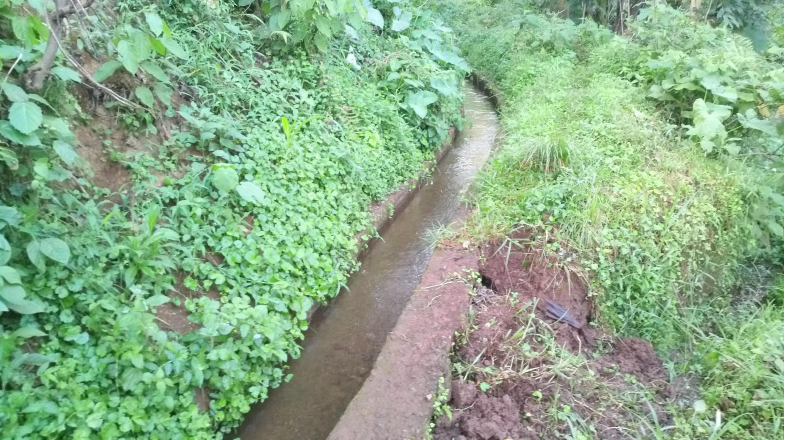
Figure 4. Furrows alongside the deep gorge of Ona River valley, Marangu (photo by Innocent Pikirayi). Archaeological surveys reveal for the first time how Chagga engineers diverted water from mountain rivers, into furrows. This involved the construction of low embankment of stones and boulders at convenient points, where the water flow rate was minimal. Where valleys are deep, furrows run along hillsides for many kilometres until they reach the villages. Archaeological surveys also show some furrows originating from the deep forest higher up the mountain, meandering downslope towards the villages. Evidently, Chagga engineers meticulously mapped the landscape to allow for construction of furrows along gradients that would deliver water supplies to the villages located downslope with more than adequate velocity and quantity. At times, such villages had to be located some distance from the furrow points intake to allow the construction of appropriate water infrastructures to capture and divert the water from the rivers. Several furrows could be cut from the same river and one furrow could have numerous twigs or branches. In some cases, branches from the main channels extend to reach all parts of the village where each homestead is allowed to deviate a stream into the adjacent banana grove (Figure 3). Thus, the construction of water infrastructures in the lower slopes of Mt Kilimanjaro resulted in the emerge over time of complex irrigation systems among the Chagga, linking their home gardens ( vihamba ) with regulated and managed water flows from the rivers flowing from the rainforest. At some point, furrows join to form one bigger furrow (Figure 2). From this point, secondary and tertiary channels (Figure 5) may spread, building a network of flowing water arteries [18].